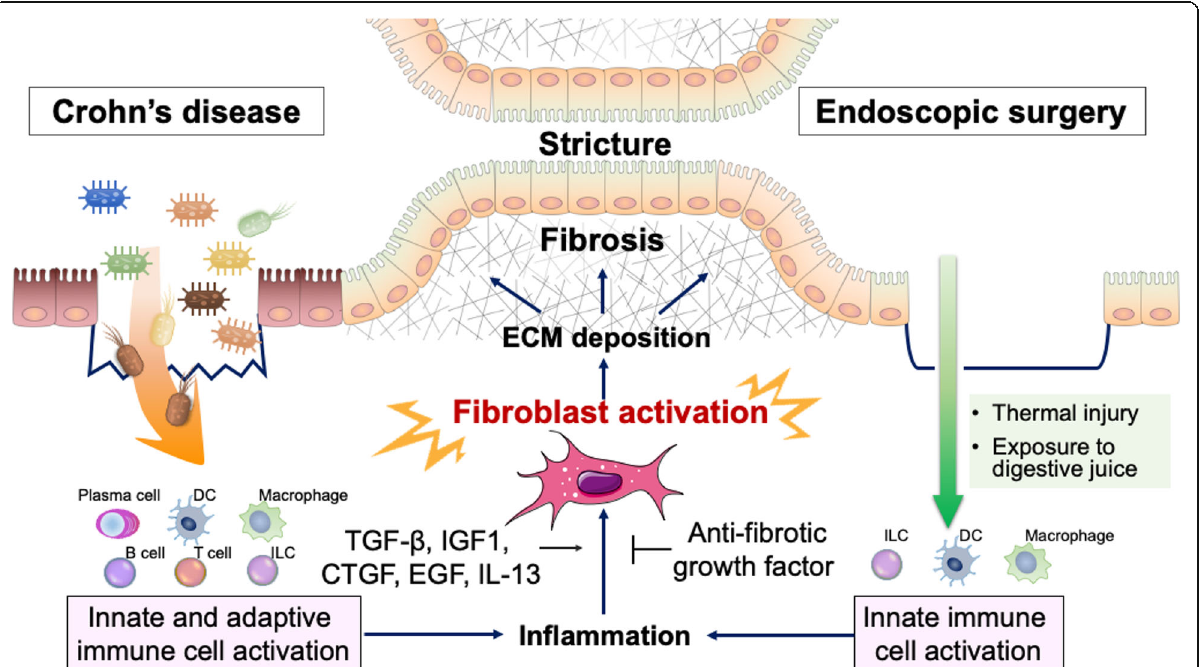
Fig. 2 Pathophysiology of GI fibrosis. Crohn ’ s disease activates innate and adaptive immunity because of genetic abnormalities and the intestinal microflora. Endoscopic treatment activates innate immune cells through thermal injury, exposure to digestive fluid, and submucosal injection, which are strong triggers for ECM-producing cells that cause GI